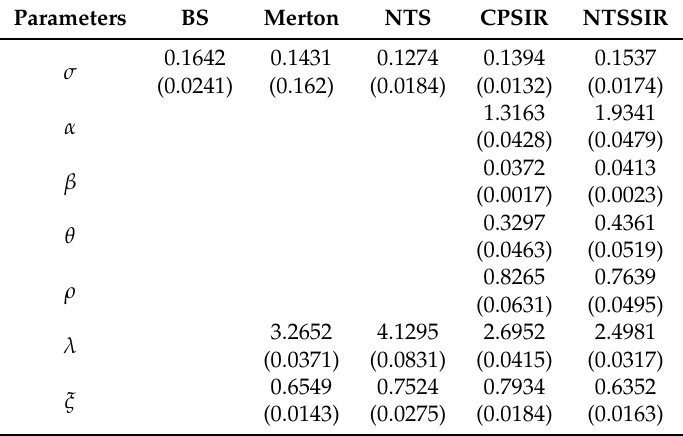
Table 1. Parameter estimate. This table shows the estimated parameter on 15 April 2020. The parameters are back out using loss function MLSE. For each parameter, we report the mean level and the standard deviation (in